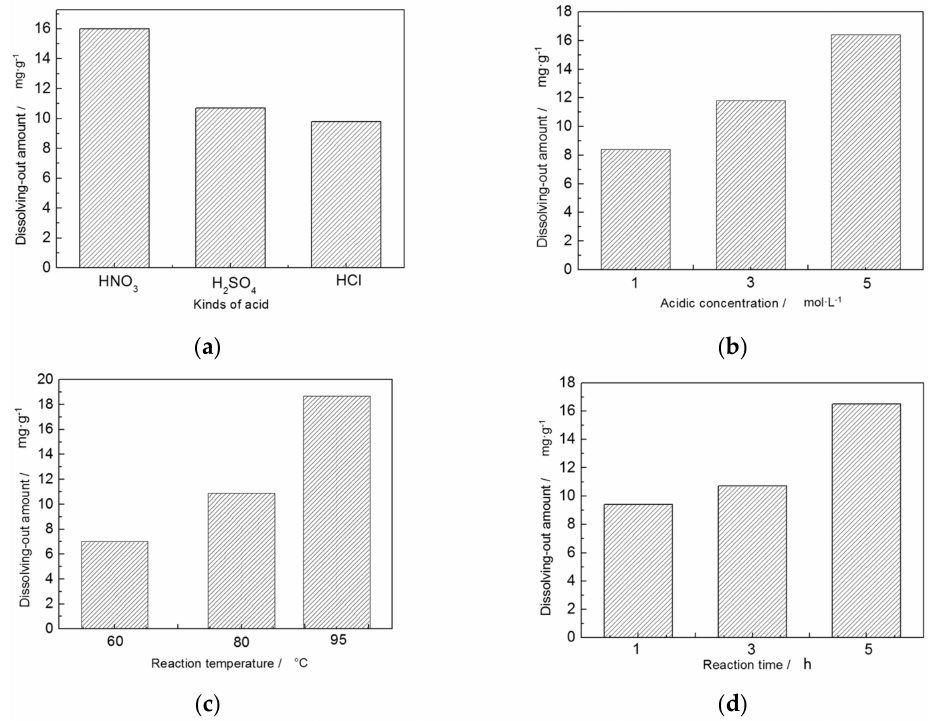
Figure 5. Effect of ( a ) kinds of acid; ( b ) acid concentration; ( c ) reaction temperature; and ( d ) reaction time on dissolving-out amount of Al 3+